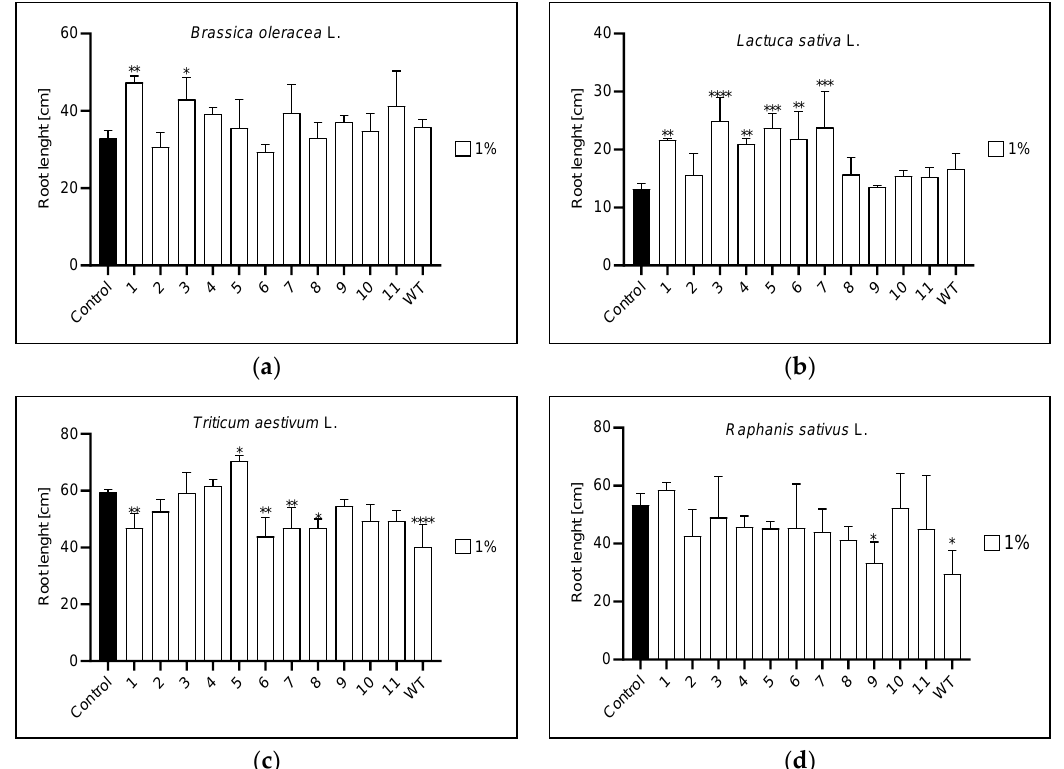
Figure 5. Root length of broccoli ( a ), lettuce ( b ), wheat ( c ), and radish ( d ) sprouts treated with 1% concentration for all algae clones tested (1-11, WT) and control (Control). Values represent mean ± SD, n = 10 plants, * p < 0.1, ** p < 0.01, *** p < 0.001, **** p < 0.0001 compared to control (ANOVA and Dunnett’s a posteriori test).